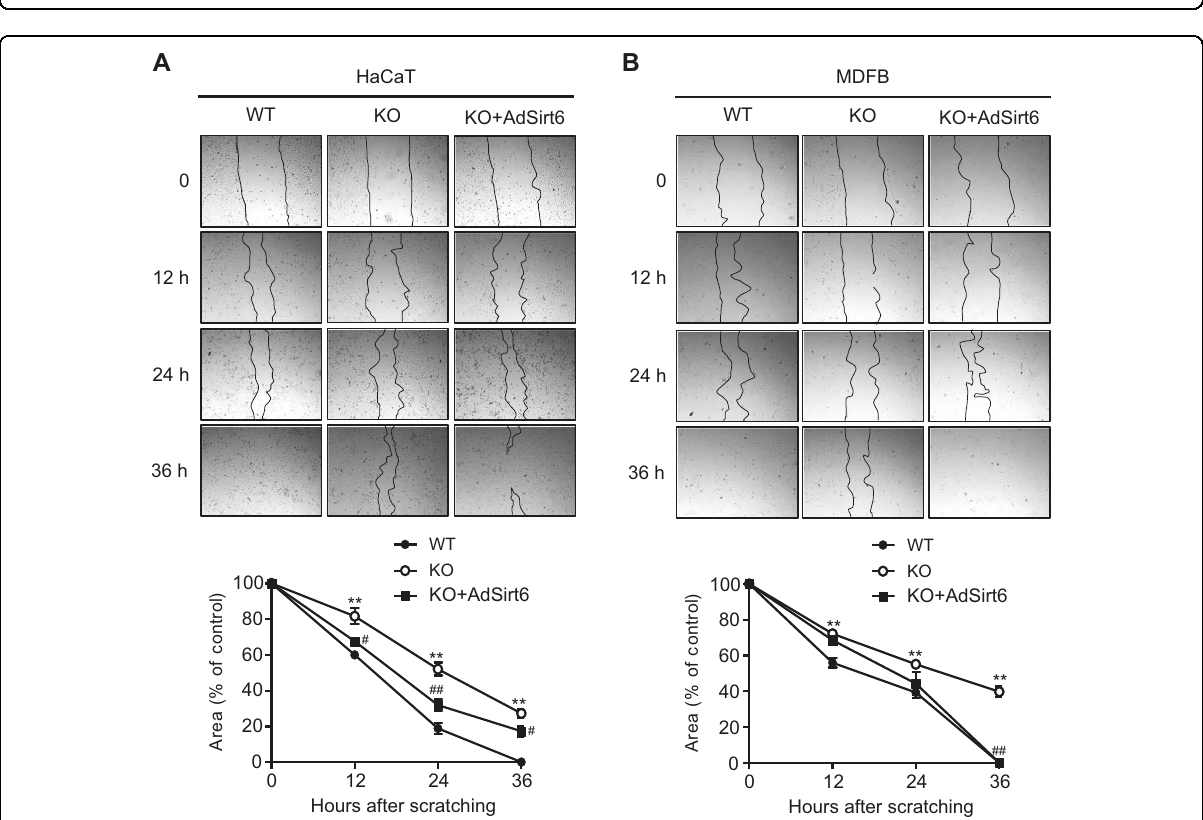
Fig. 5 Temporal changes in the expression of markers for M1 and M2 macrophages in wound sites. a , b The mRNA levels of M1 and M2 marker genes in the wound site were determined by real-time RT-PCR ( n = 8). c , d The levels of M1 and M2 cytokines in the tissue were measured using ELISA ( n = 6). Values represent the mean ± SEM. * p < 0.05 and ** p < 0.01 vs. WT